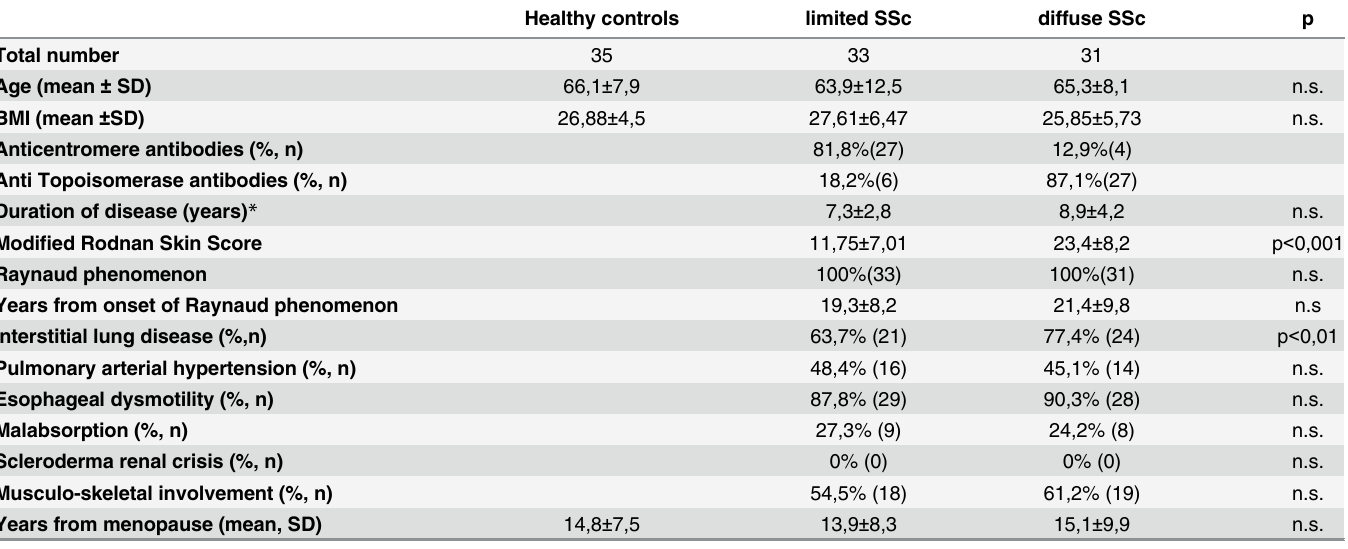
Table 1. Demographic and clinical characteristics of SSc patients and healthy controls. Healthy controls limited